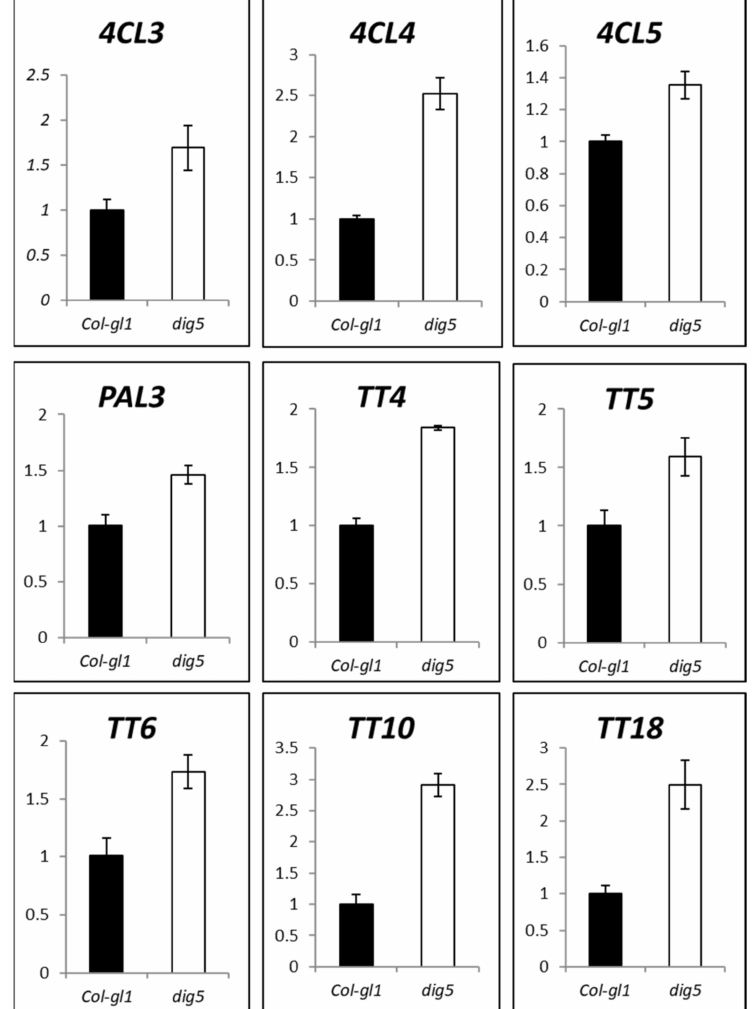
Figure 9. Expression of flavonoid biosynthetic genes in dig5 . Shown are quantitative real-time PCR detection of transcript levels in roots of 2-week-old dig5 and wild type (Col- gl1 ) seedlings. 4CL3/4CL4/4CL5 encode 4-coumarate:CoA ligase 3/4/5; PAL3 encodes phenylalanine ammonia-lyase 3; TT4 encodes chalcone synthase (CHS); TT5(At3g55120) encodes chalcone isomerase (CHI); TT6 ( At3g51240) encodes flavanone 3-hydroxylase; TT10 (At5g48100) encodes a laccase-like polyphenol oxidase; TT18 (At4g22880) encodes anthocyanidin synthase